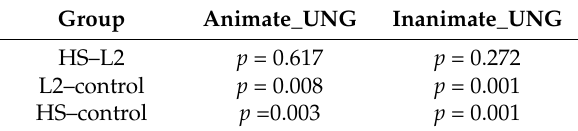
Table 5. AJT: independent samples t -tests of ungrammatical (UNG) sentences (CLLDs). Group Animate_UNG Inanimate_UNG HS–L2 p = 0.617 p = 0.272 L2–control p = 0.008 p = 0.001 HS–control p =0.003 p = 0.001